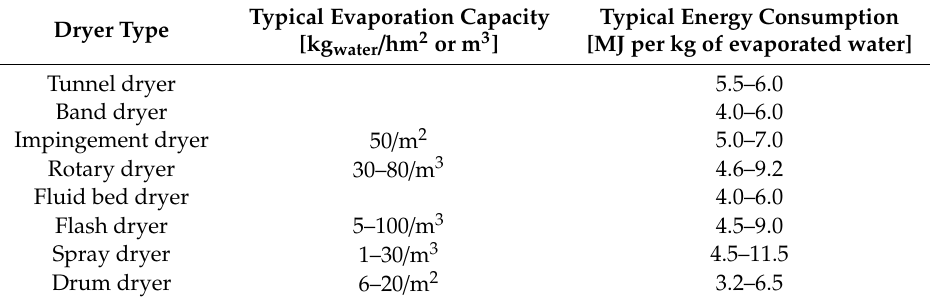
Table 1. Energy consumption for selected dryers